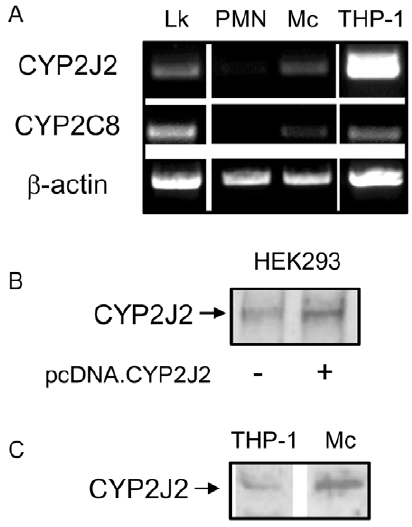
Figure 3. Human monocytes contain epoxygenases CYP2J2 and CYP2C8. (A) CYP2J2 and CYP2C8 mRNA determined by RT-PCR are expressed in human peripheral leukocytes (Lk), monocytes (Mc) and the THP-1 cell line, but not polymorphonuclear cells (PMNs). Confirmation of CYP2J2 protein in human monocytes and THP-1 cells was performed by western blotting. (B) HEK293 cells transfected with empty vector (-) compared to HEK293 cells transfected with expression plasmid for CYP2J2 ( + ) was used as a positive control. (C) CYP2J2 protein in human THP-1 cells and monocytes (Mc). Figures are representative of n=3 2 4 independent